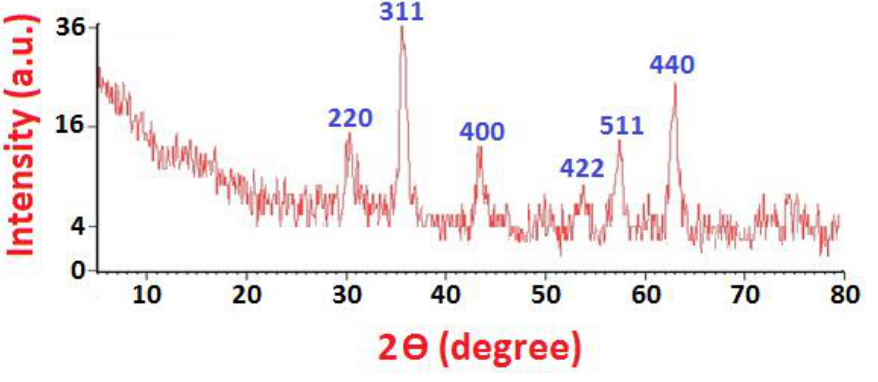
Figure 2. XRD pattern of Fe 3 O 4 MNPs.